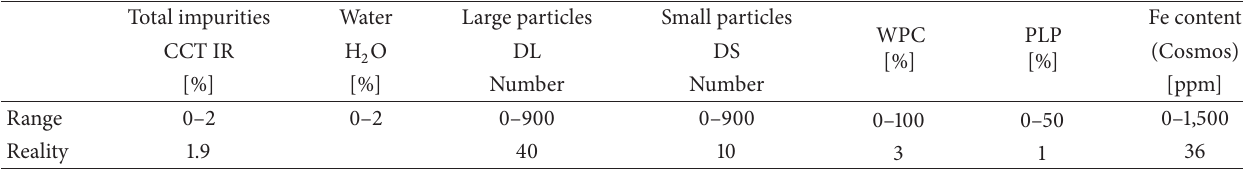
Table 4: The measurement results for sample A.